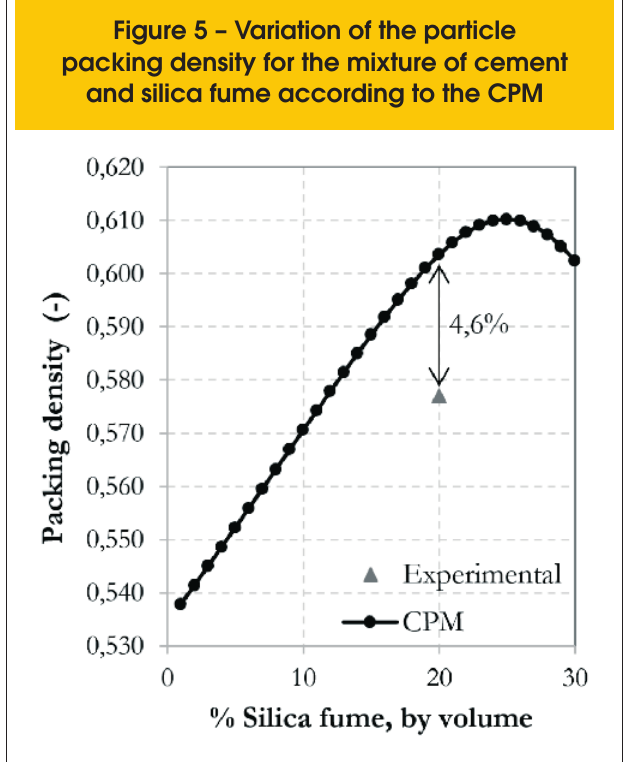
Figure 5 – Variation of the particle packing density for the mixture of cement and silica fume according to the